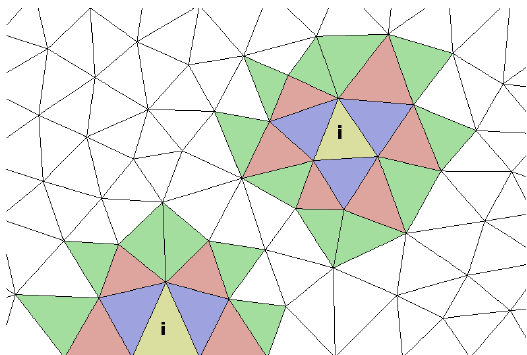
Figure 1. Layers of cells added at each iteration: in yellow, considered cell; in purple, initial neighbours; in red, the cells added at the first iteration; in green, the cells added at the second iteration—two-dimensional example.